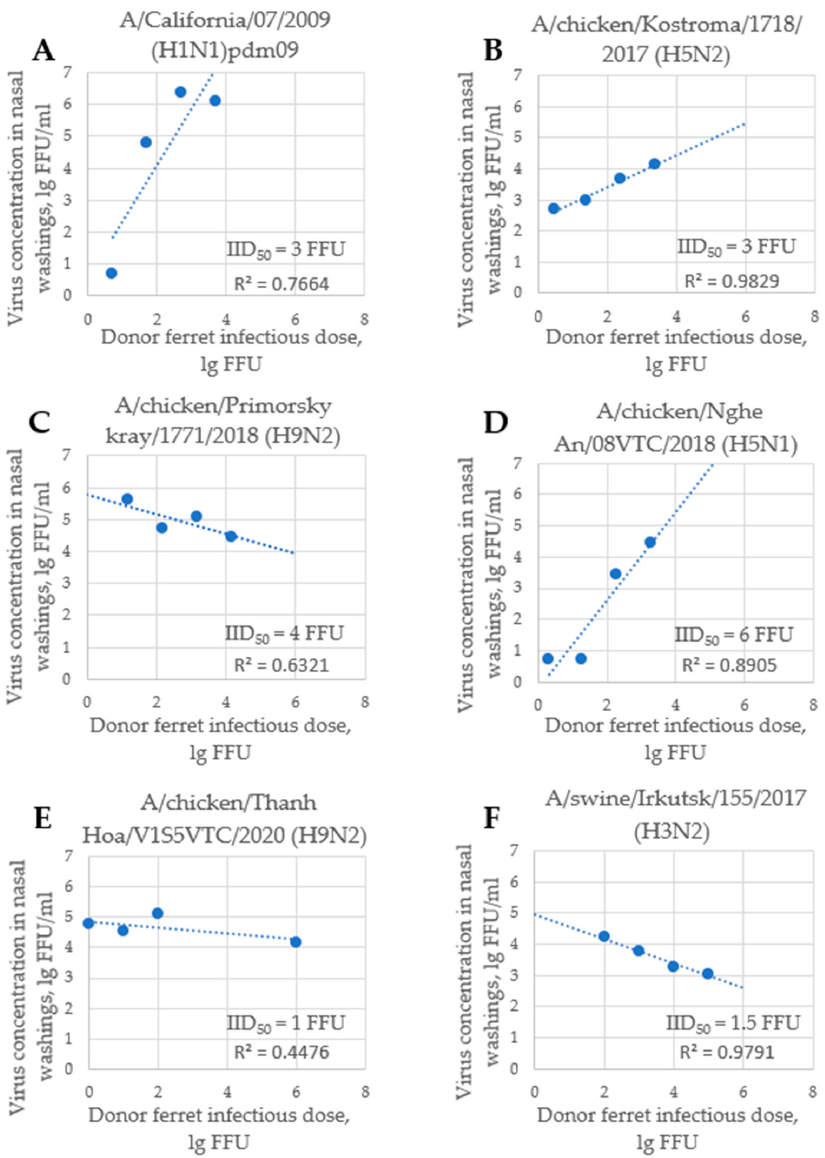
Figure 2. Effect of intranasal infectious dose (IID) on virus load in the nasal washings of donor ferrets, infected with different doses of influenza virus strains: ( A ) A/California/07/2009 (H1N1)pdm09, ( B ) A/chicken/Kostroma/1718/2017 (H5N2), ( C ) A/chicken/Primorsky Krai/1771/2018 (H9N2), ( D ) A/chicken/Nghe An/08VTC/2018 (H5N1), ( E ) A/chicken/Thanh Hoa/V1S5VTC/2020 (H9N2), ( F ) A/swine/Irkutsk/155/2017 (H3N2). The X axis—IID in donor ferrets. The Y-axis—virus titer in nasal washings of donor